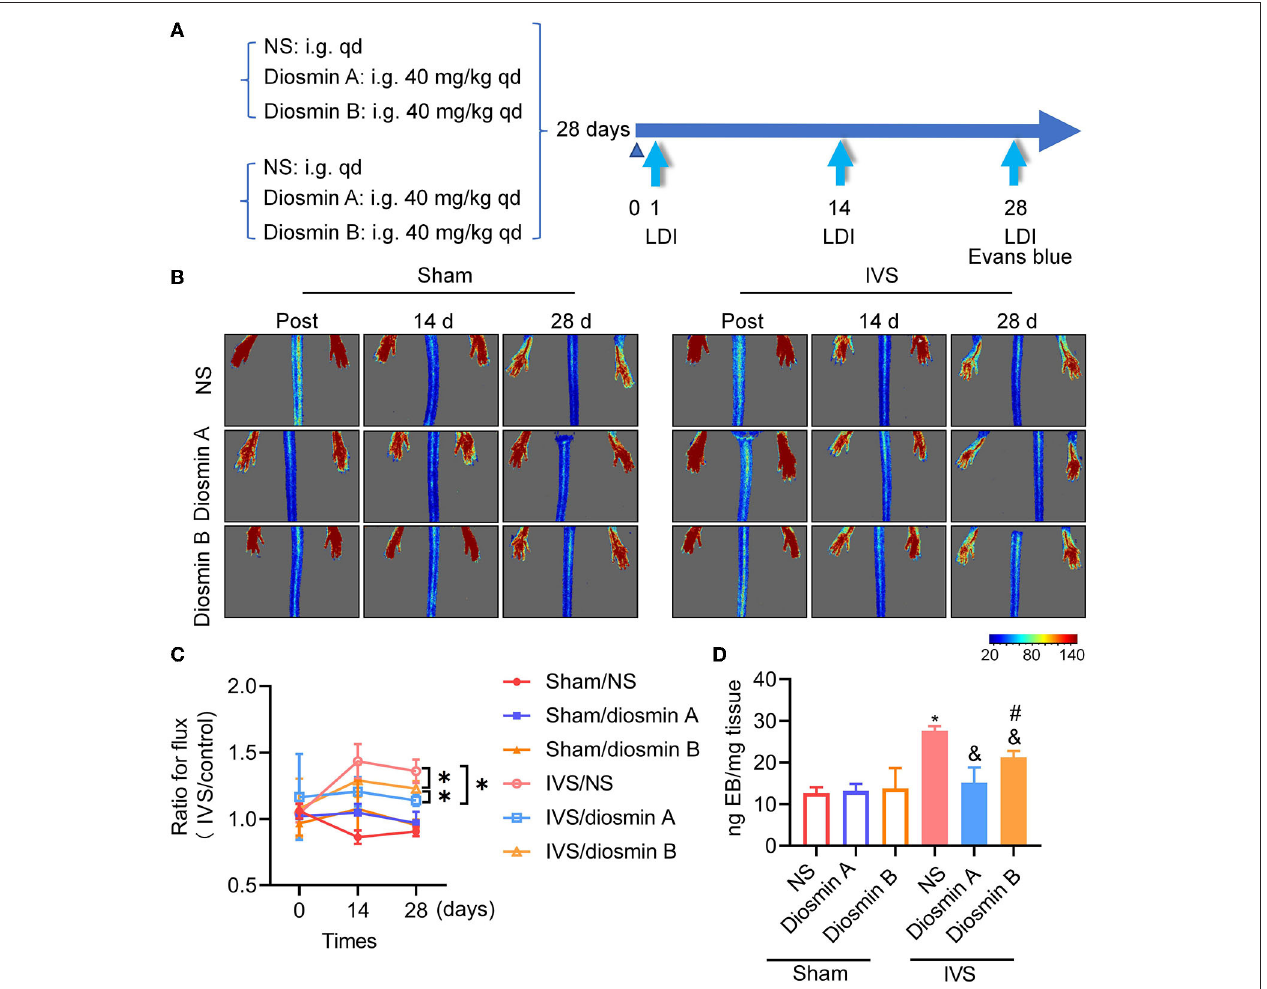
FIGURE 2 | Diosmin alleviates permeability in mouse model of iliac vein stenosis. (A) Schema of experimental procedure. (B,C) The mice were detected by laser speckle on the day after surgery (post), 14 and 28 days after surgery. Sham/normal saline (NS; n = 3), sham/diosmin A ( n = 3), sham/diosmin B ( n = 3), IVS/NS ( n = 6), IVS/diosmin A ( n = 7), and IVS/diosmin B ( n = 7). (B) The serial color-coded perfusion images were presented. (C) Quantification analysis of the blood perfusion achieved from laser speckle images. * p < 0.05 (Unpaired t -test). (D) Quantitative analysis of Evans blue content in semi-membranosus (SM) muscle of mice. Sham/NS ( n = 3), sham/diosmin A ( n = 3), sham/diosmin B ( n = 3), IVS/NS ( n = 6), IVS/diosmin A ( n = 6), and IVS/diosmin B ( n = 6). * p < 0.05 vs. sham/NS; & p < 0.05 vs. IVS/NS; # p < 0.05 vs. IVS/diosmin A (ordinary one-way ANOVA’s multiple-comparisons test). IVS, iliac vein